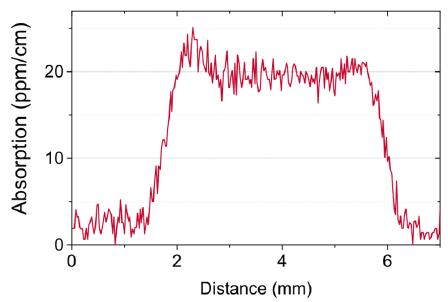
Figure 2. PCI absorption z-scan of the Spectrosil 2000 substrate, with the front surface at 1.8 mm and back surface at 6.0